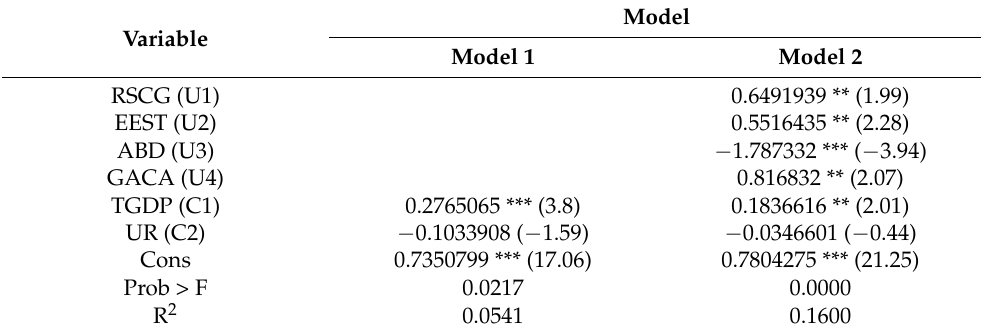
Table 4. Robustness test